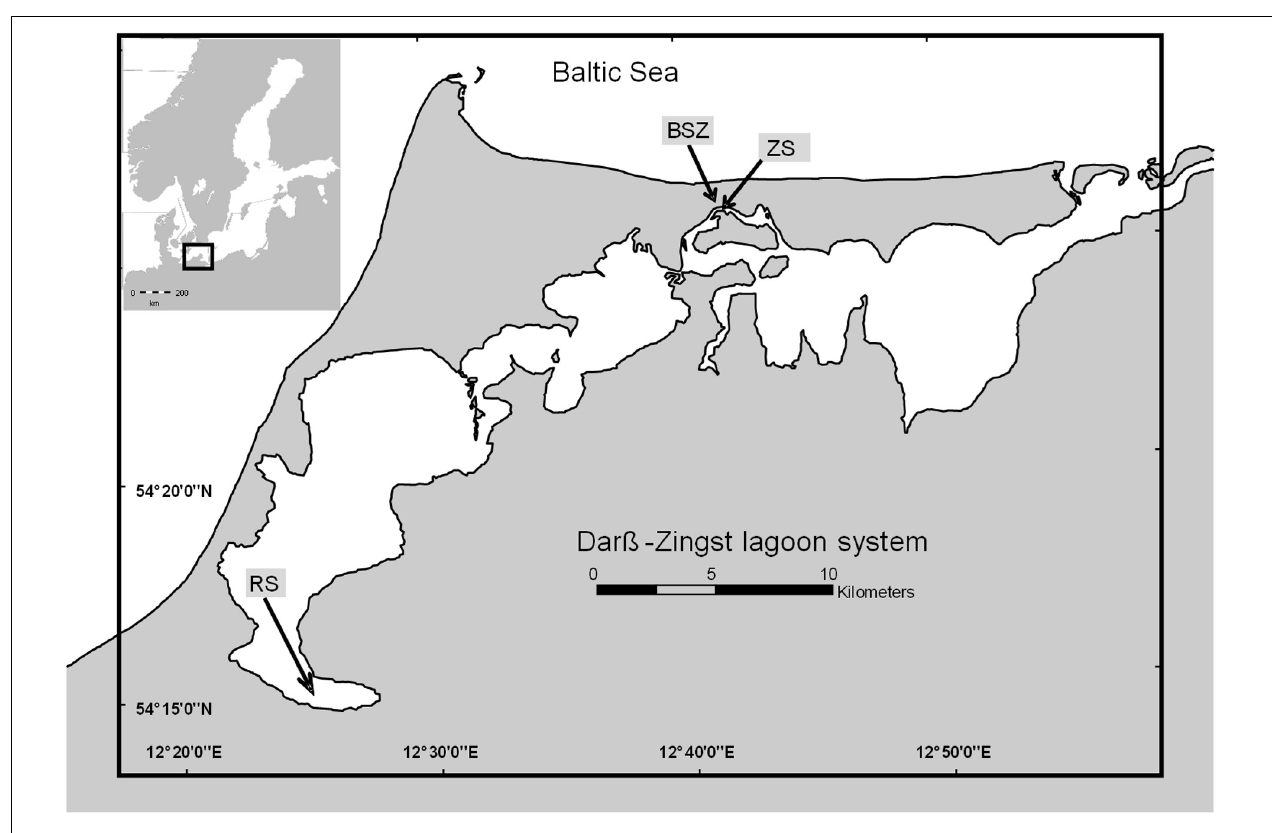
FIGURE 1 | Map of the Darß-Zingst lagoon system (drawn with ArcGIS version 10.2). RS, Ribnitzer See; ZS, Zingster Strom.